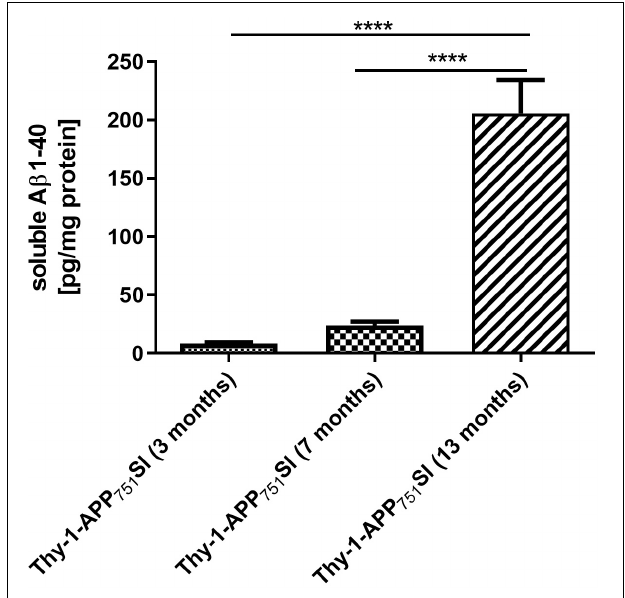
FIGURE 1 | Soluble human A β 1 − 40 levels in homogenates isolated from brains of 3, 7, and 13 months old Thy1-APP 751 SL mice determined using ELISA. Data represent means ± SEM. n = 10; One-Way ANOVA with Tukey’s post-hoc test with **** p < 0.0001.